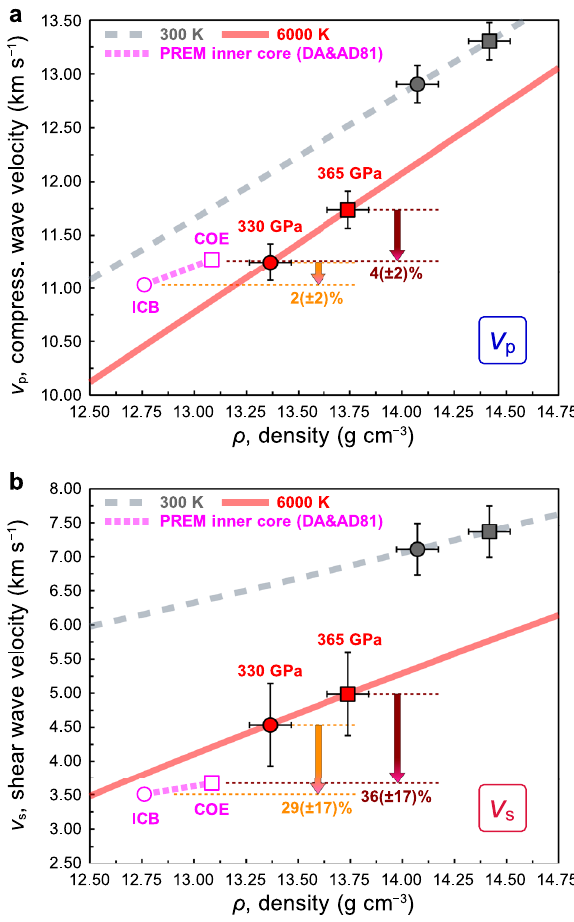
Fig. 5 | Comparison of v ‒ ρ relations ofhexagonal close-packed (hcp) iron, iron alloys Fe 0.89 Si 0.11 and Fe 0.86 Ni 0.14 , and iron sulphur compound Fe 3 S with Pre- liminary reference Earth model (PREM) at the inner core boundary (ICB, 330GPa,and6000K)andcentreoftheEarth/core(COE,365GPa,and6000K) conditions. The v p ‒ ρ ( a ) and the v s ‒ ρ ( b ) relations ofeach material. The circleand square symbols indicate ICB and COE conditions, respectively. The coloured symbols are as follows: black is hcp-iron from this study (pressure is evaluated by theDewaeleetal. 3 ),redisFe 0.89 Si 0.11 (6wt%silicon) 25,26 ,greenisFe 0.86 Ni 0.14 (15wt% nickel) 27,28 , blue isFe 3 S 29,30 , and magenta (open symbol) isPREM 1 . The v ‒ ρ relations for hcp-iron at the ICB and COE conditions are determined by this work (see text and Methods). The v ‒ ρ relations of other iron alloys and iron compound are cal- culatedfrompreviousstudiesonsoundvelocityandequationsofstate 25 – 30 ,andthe present temperature dependence of hcp-iron (details are in Methods) for FeNi 0.15 and Fe 3 S. The magenta triangles represent the potential v ‒ ρ relations of the iron compounds consisting of three endmembers (hcp-iron, Fe 0.89 Si 0.11 , and Fe 3 S) (lighter and darker colours indicate ICB and COE conditions, respectively). The error bars represent 1 σ uncertainties for hcp-iron.